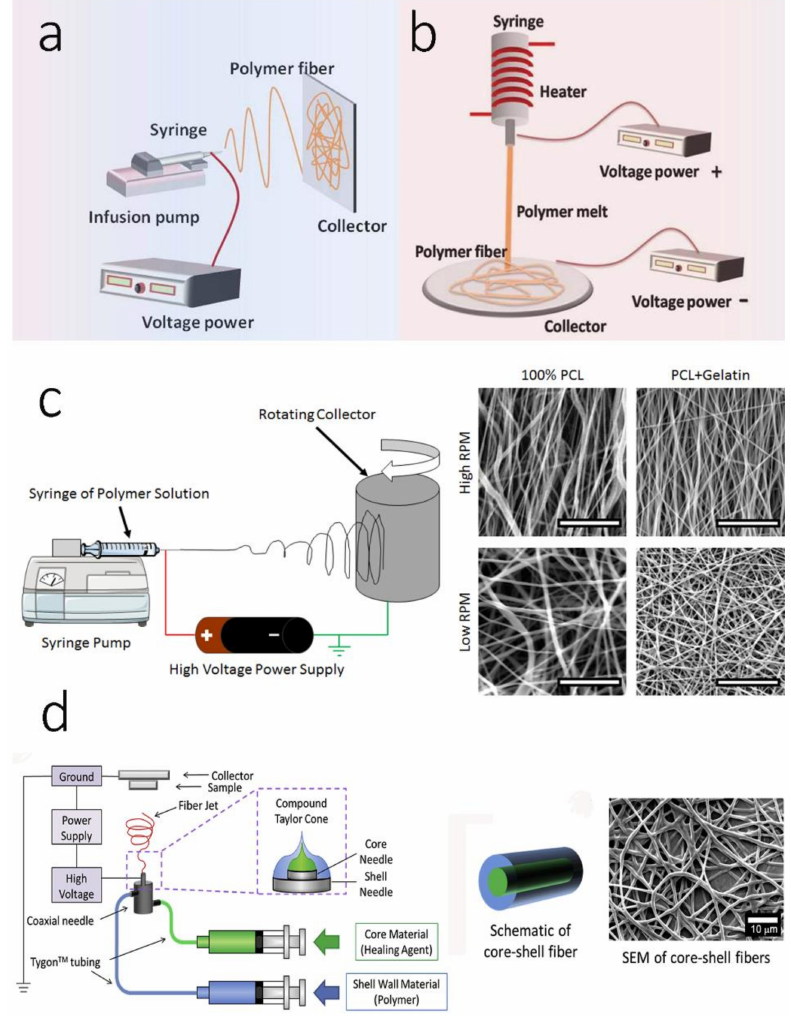
Figure 2. Schematic images of different electrospun fabrication techniques: ( a ) monoaxial electro- spinning; ( b ) melt electrospinning; ( c ) aligned electrospinning; ( d ) coaxial electrospinning. ( a , b )